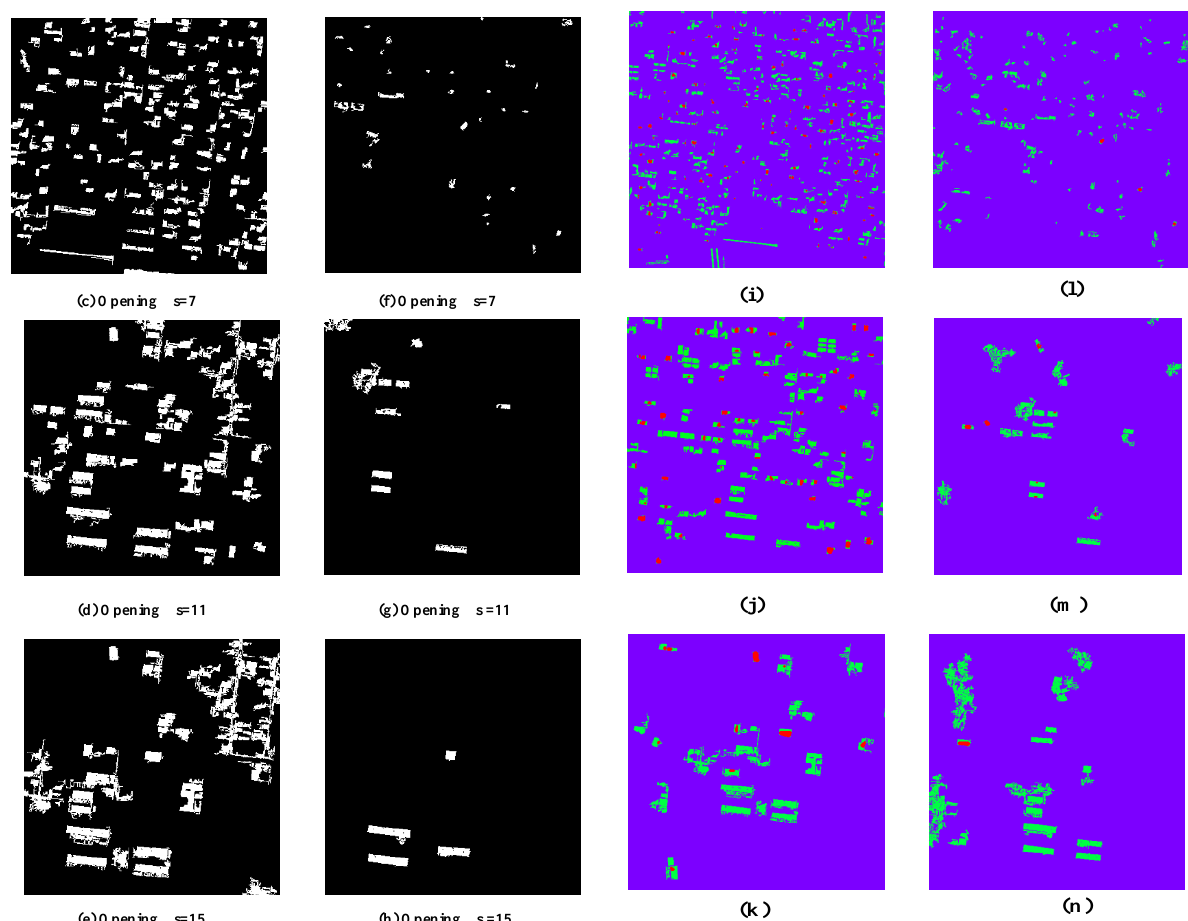
Figure.4 Result of the building extraction according to approached method. Identified buildings are shown in red color, (i),(l) pre and post event building roofs corresponded to SE=7, (j),(m) pre and post event building roofs corresponded to SE=11 and (k),(n) show the pre and post event building roofs corresponded to SE=15